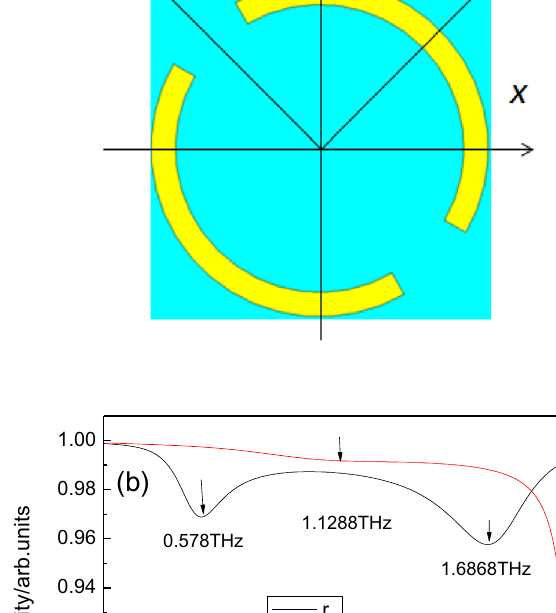
Fig. 4c. Within the range 0.97 to 1.52 THz, the phase differ- ence ranges from − 180° to − 140°, in which incident linearly polarized terahertz waves are converted into right-handed elliptically polarized terahertz waves. Within the ranges 0.61–0.97 THz and 1.52–1.96 THz, the phase difference